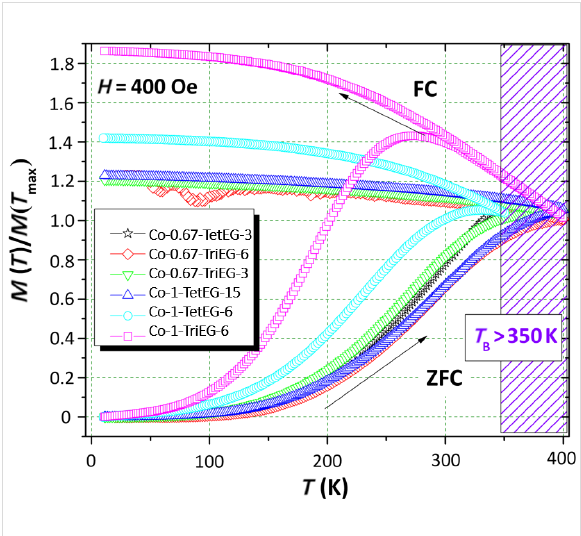
Figure 5: Thermal variation of the normalized DC magnetic magneti- zation measured in ZFC and FC